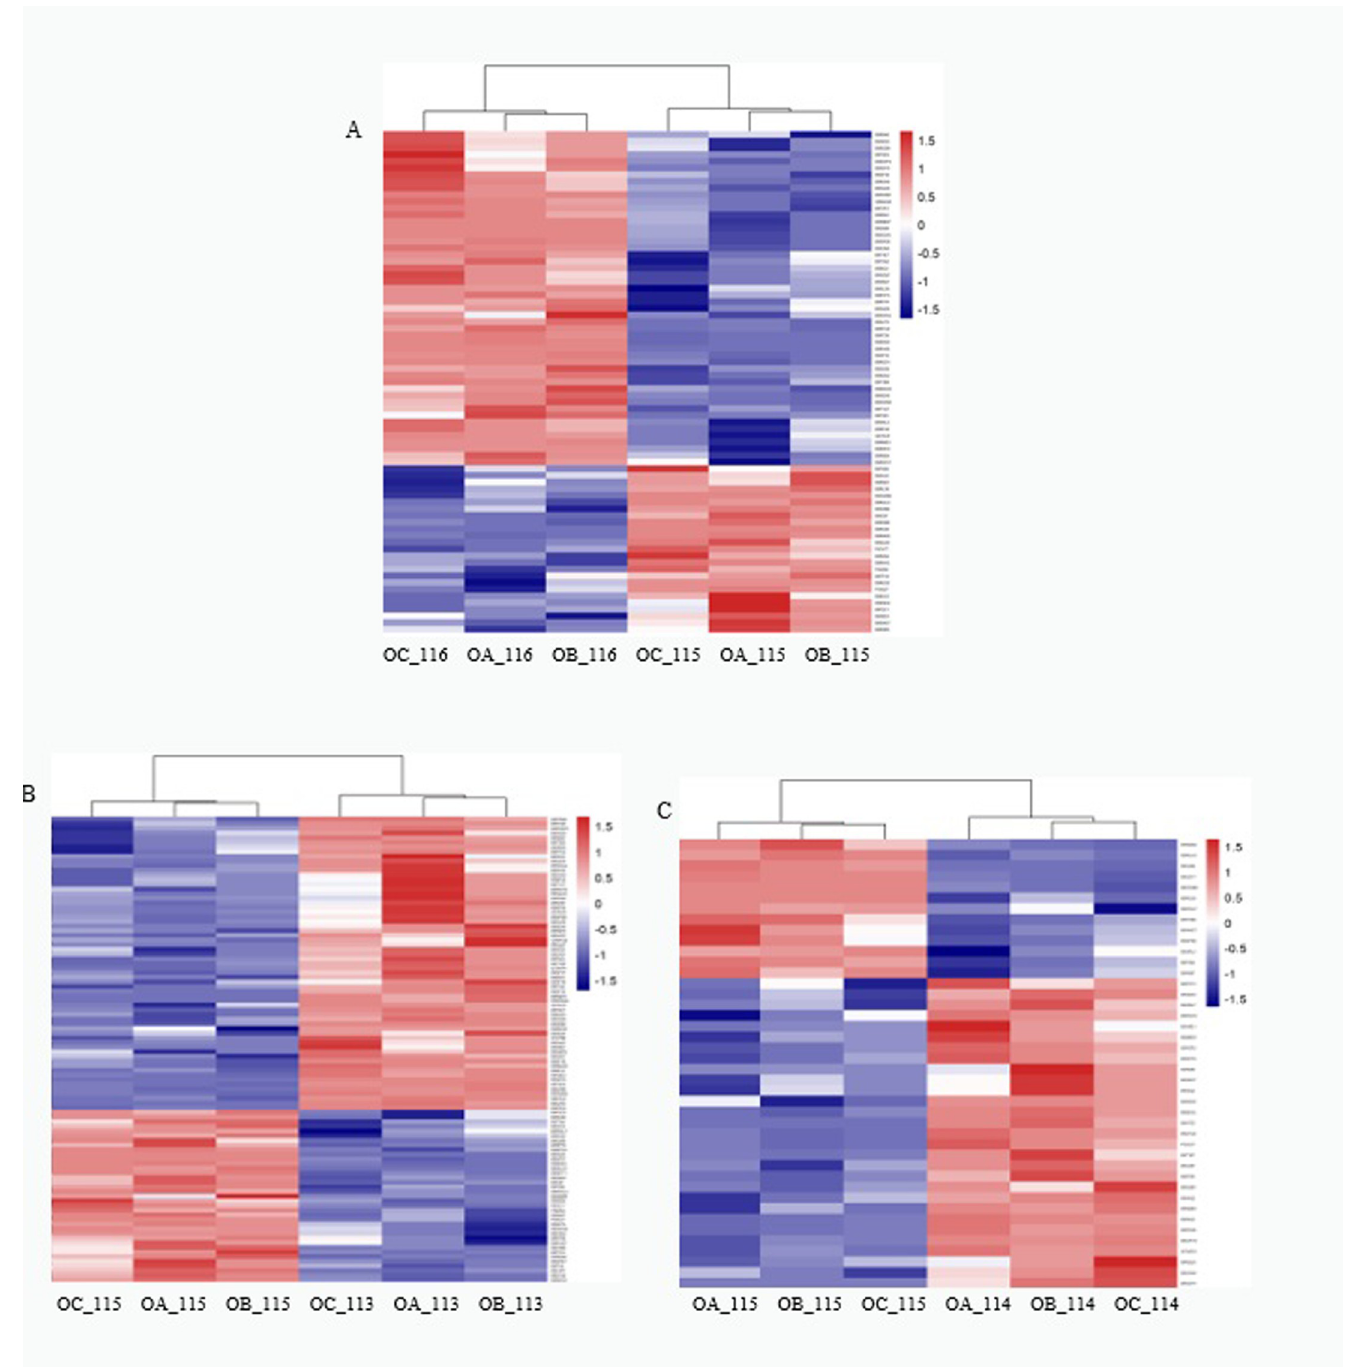
Fig 5. Differential protein cluster analysis. Note: A: ZA_VS_CK differential protein cluster analysis; B: ZB_VS_CK differential protein cluster analysis; C: ZC_VS_CK differential protein cluster analysis.